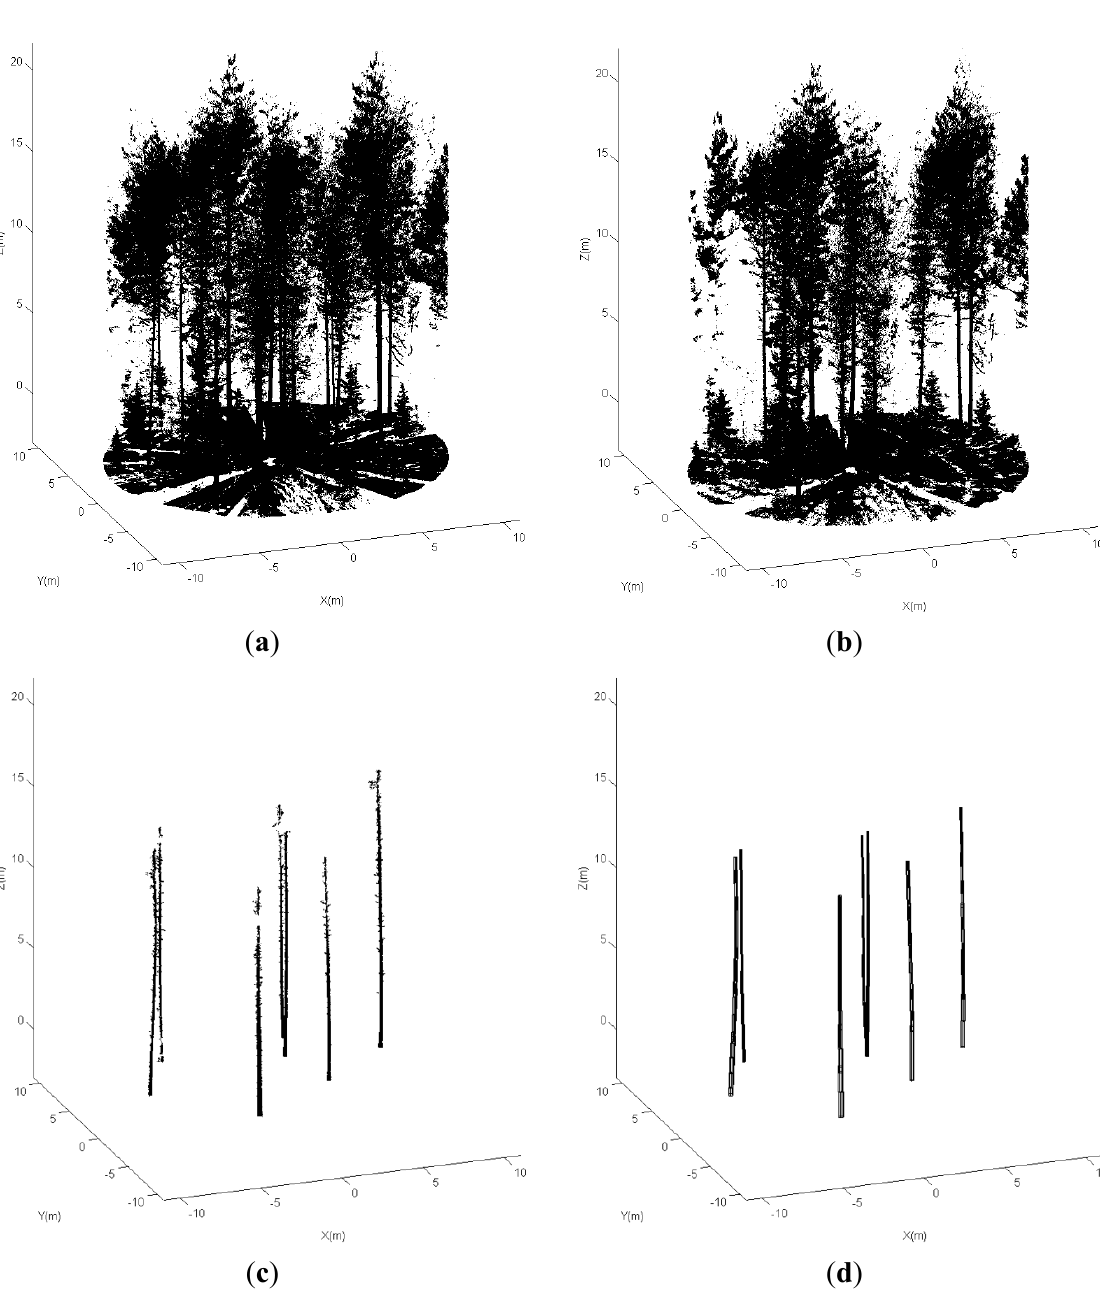
Figure 5. The detection in forest structure over time: ( a ) the TLS data at Time I; ( b ) the TLS data at Time II; ( c ) the laser points from the changed stems; ( d ) the stem